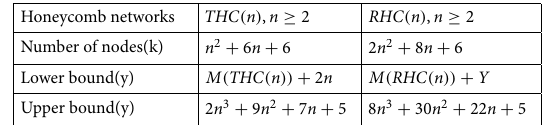
Table 1. Bounds of THC ( n ) and RHC ( n ).